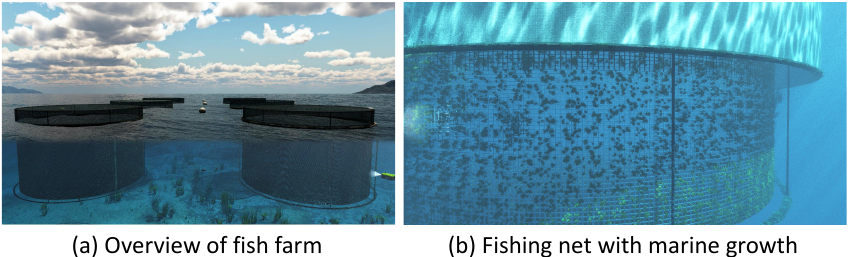
Figure 8. The virtual fishing farm. ( a ) overview of fish farm; and ( b ) fishing net with marine growth.